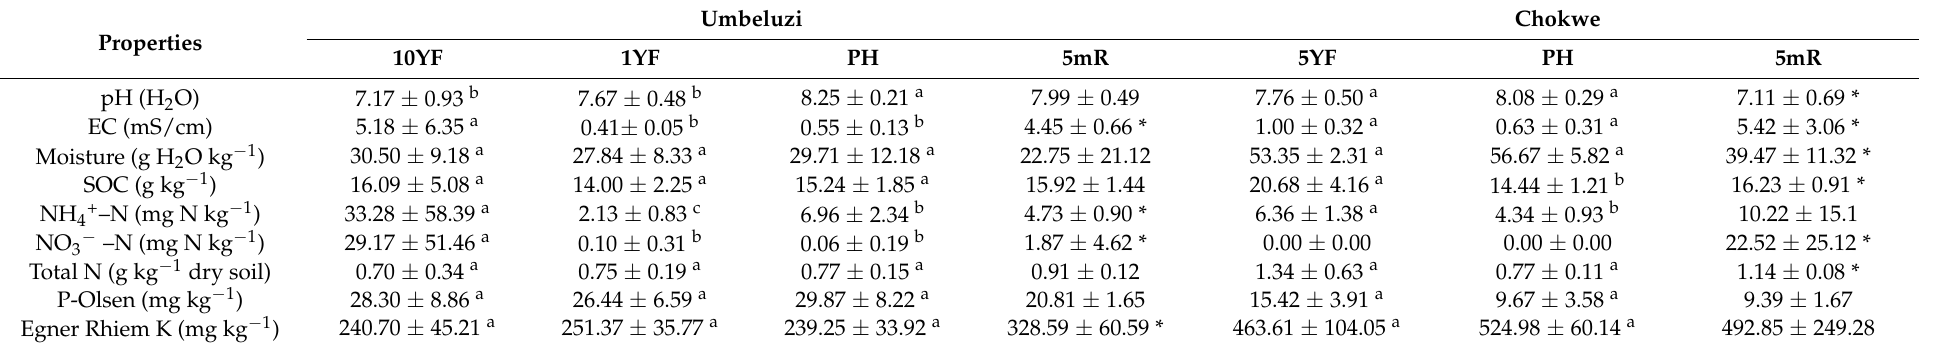
Table 2. Selected physicochemical properties of bulk